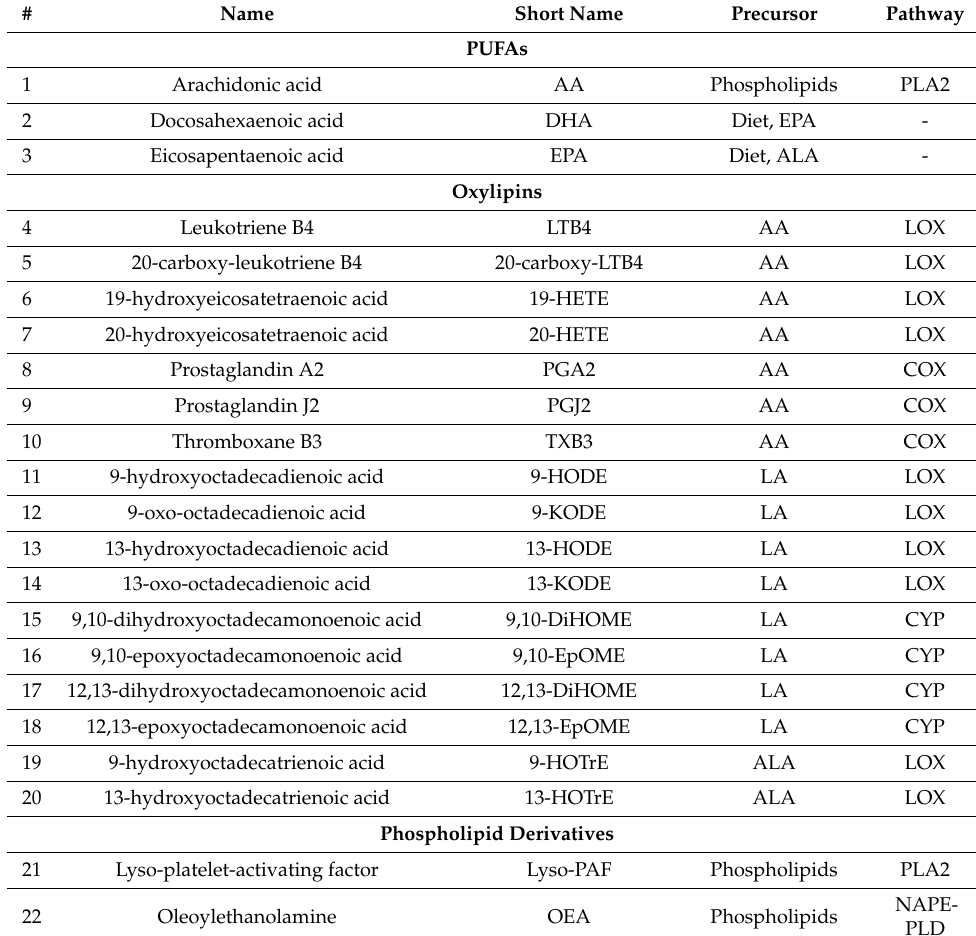
Table 2. Nomenclature of the lipid compounds detected in